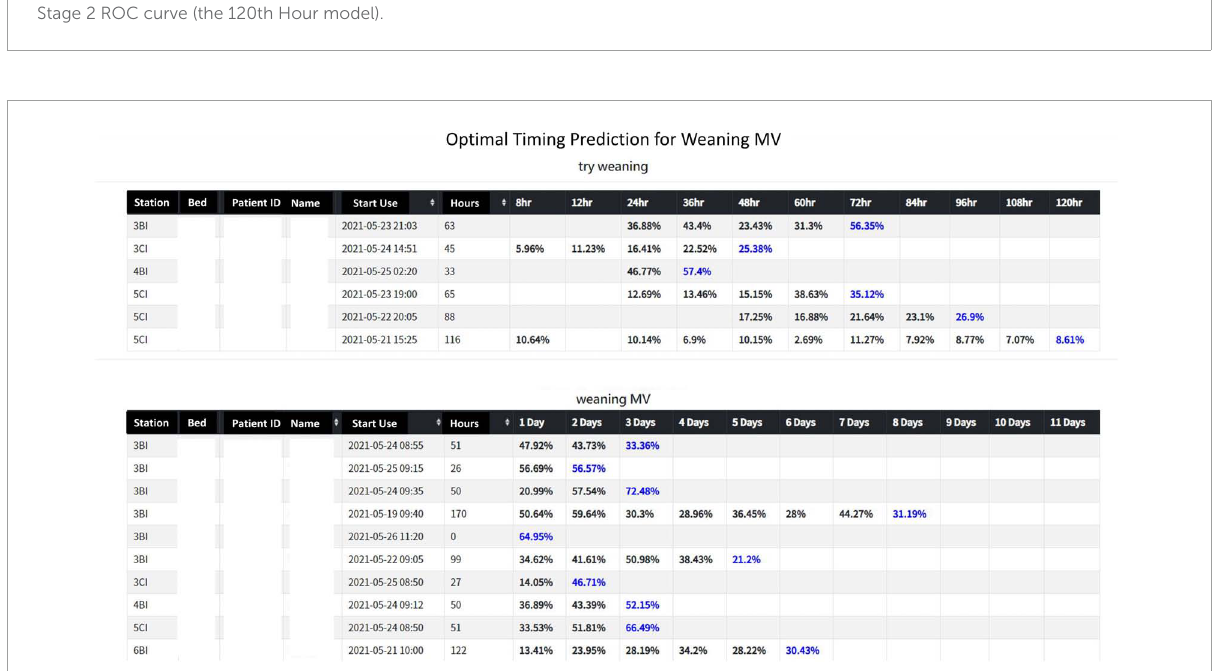
FIGURE9 A screenshot of the artificial intelligence (AI) prediction system